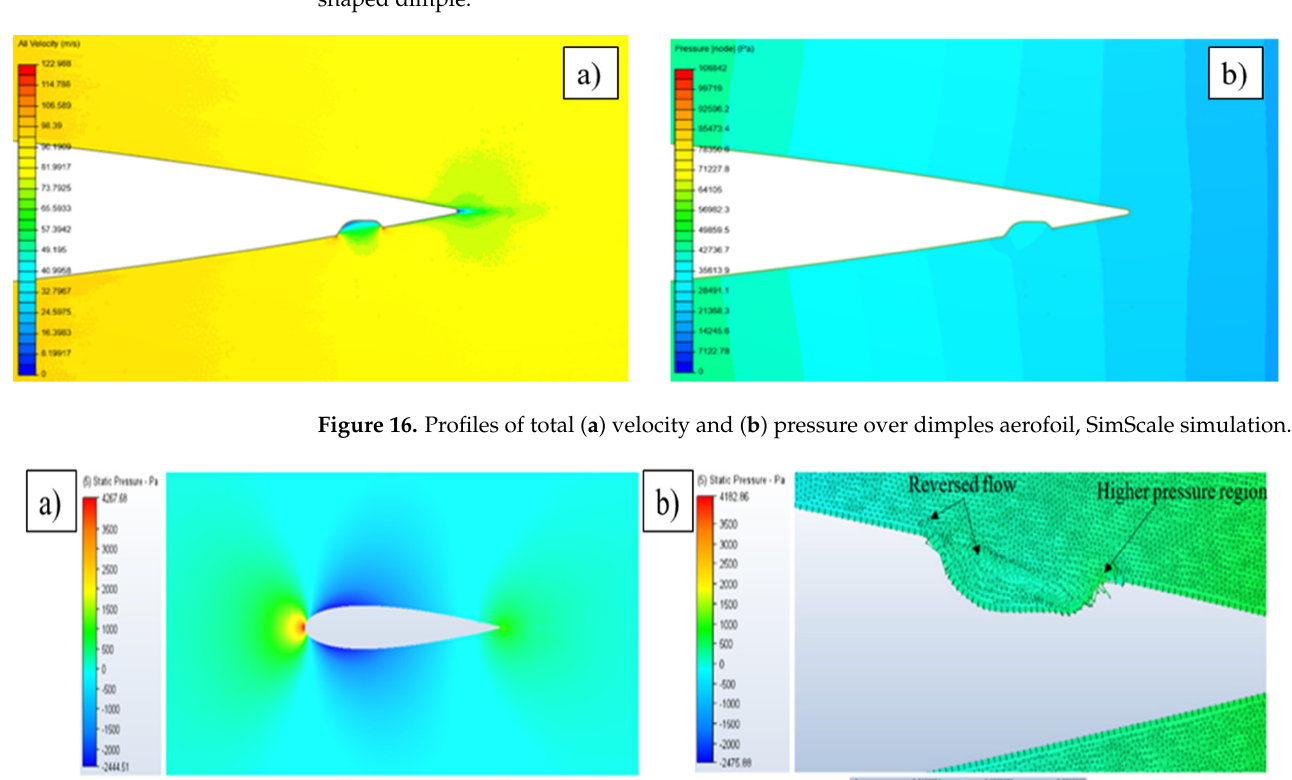
Figure 17. ( a ) Pressure gradient and ( b ) flow disturbance over unmodified 2D aerofoil.